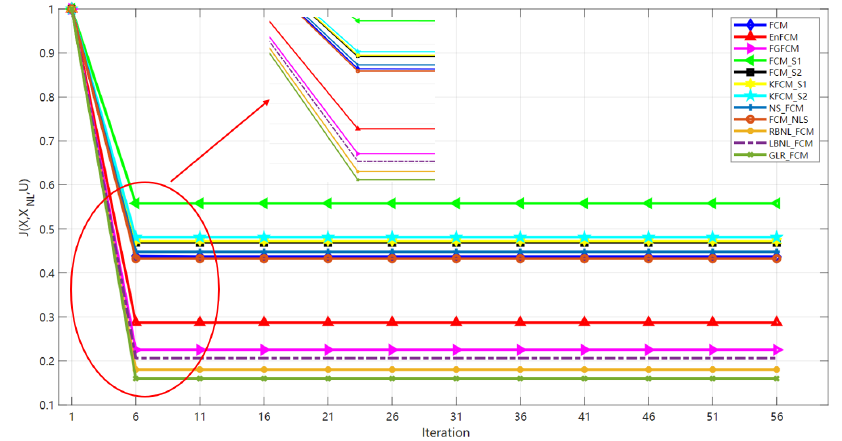
Figure 10. The objective function curve of each algorithm on the second simulated SAR